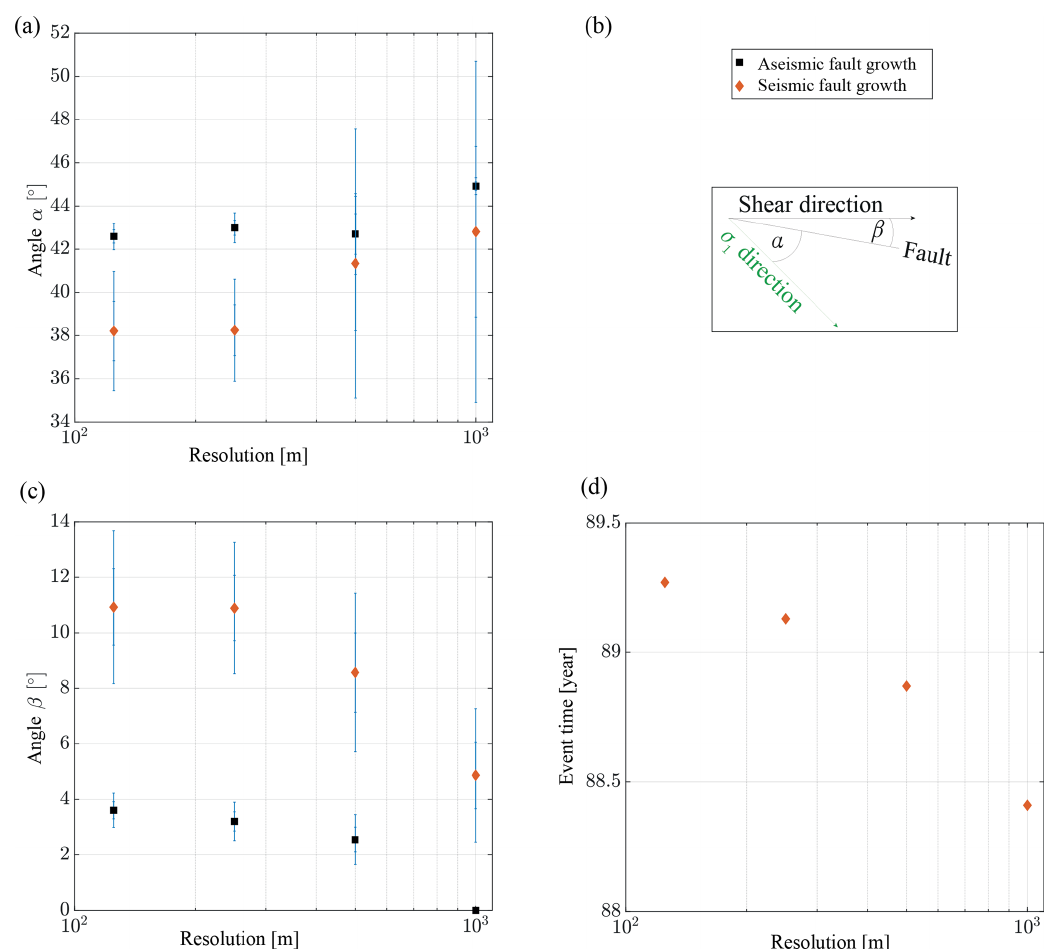
Figure A1. Convergence analysis of fault angle and earthquake time as a relation between grid resolution and fault angles and between grid resolution and earthquake time start, respectively. The analysis shows that all seismic and aseismic fault angles as well as earthquake timing converge with grid size. Color-filled symbols indicate different faulting stages. Blue error bars correspond to errors in measuring the absolute angle β and to spatial variations of the σ 1 direction at the fault tip (details are explained in Preuss et al., 2019). The solid line corresponds to the standard deviation [ − 1 σ, 1 σ ] and the dashed line to the standard deviation [ − 2 σ, 2 σ ]. (a) Grid resolution in meter versus relative fault angle α = σ 1 − β (see schematic illustration in c ). (b) Grid resolution in meters versus absolute fault angle β . (c) Fault angle legend and schematic illustration of fault angles. (d) Grid resolution in meters versus the temporal onset of the earthquake in